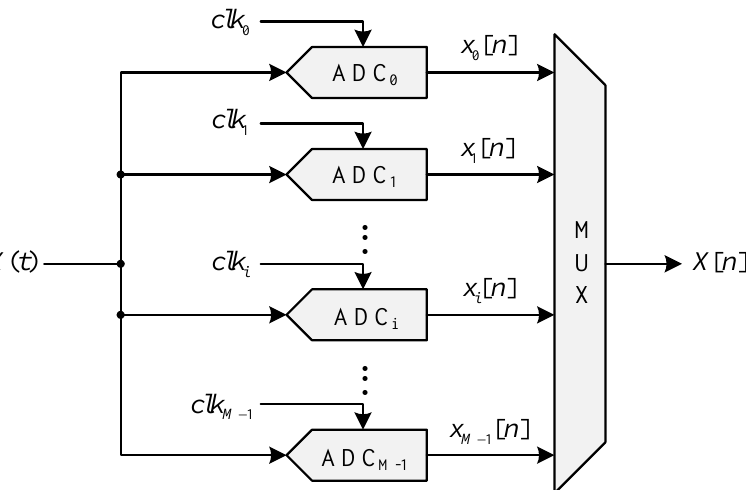
Figure 1. A block diagram of an M -channel